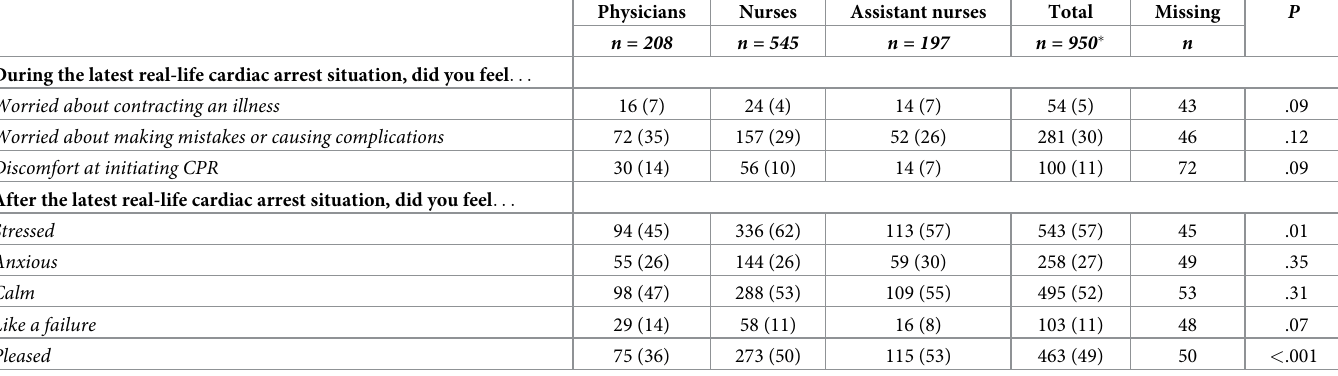
Table 3. Attitudes towards performing CPR in connection to the latest real-life cardiac arrest situation.